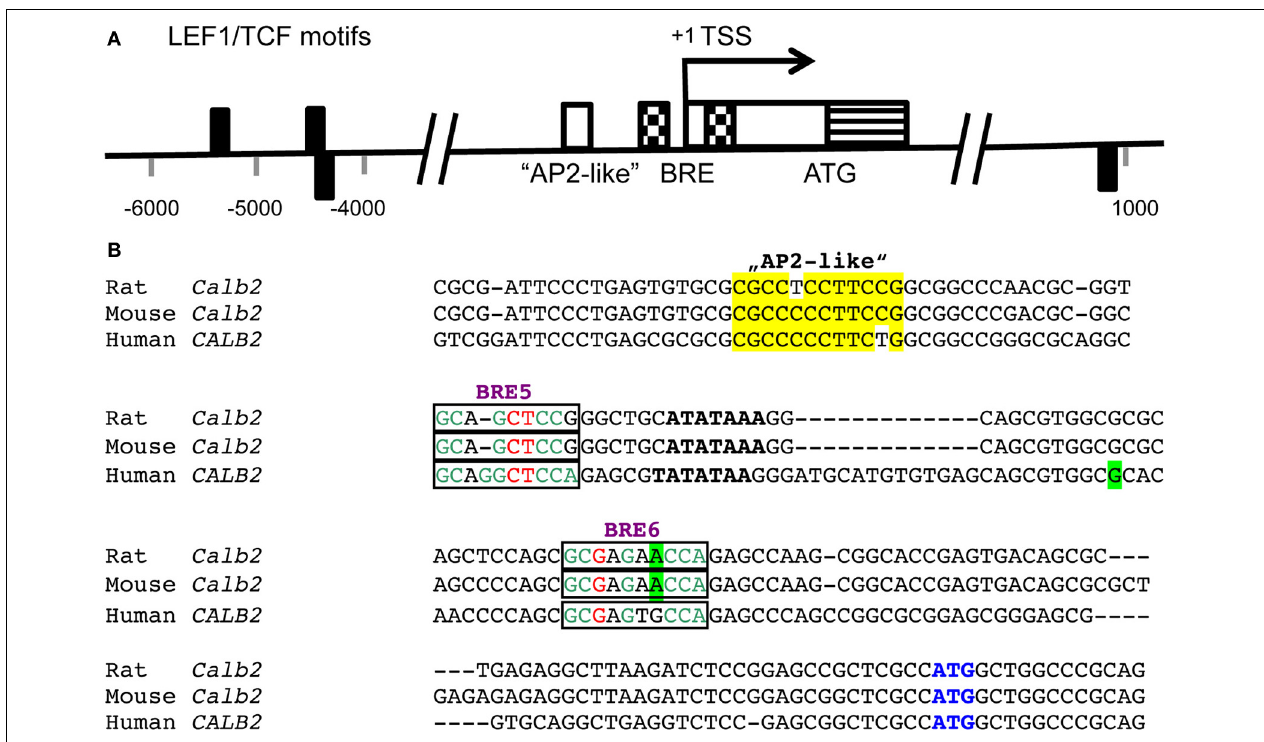
FIGURE 1 | (A) Positions of LEF1/TCF motifs (black rectangles) are present within conserved (human/rat) non-coding regions flanking the transcription start site (TSS; pos. + 1) of the CALB2/Calb2 genes and are depicted either above or below the axis depending on the strand (modified from Wisniewska et al., 2012). The consensus sequence recognized by the DNA-binding domain of LEF1/TCFs is WWCAAAG (W is either A or T). Nucleotide numbering is shown with respect to the TSS. In the region − 90/ − 80 of the mouse Calb2 gene, an “AP2-like” element (white box) is responsible for neuron-specific expression of the transcript (Billing-Marczak et al., 2002). A bipartite butyrate-responsive element (BRE; checkered boxes) surrounds